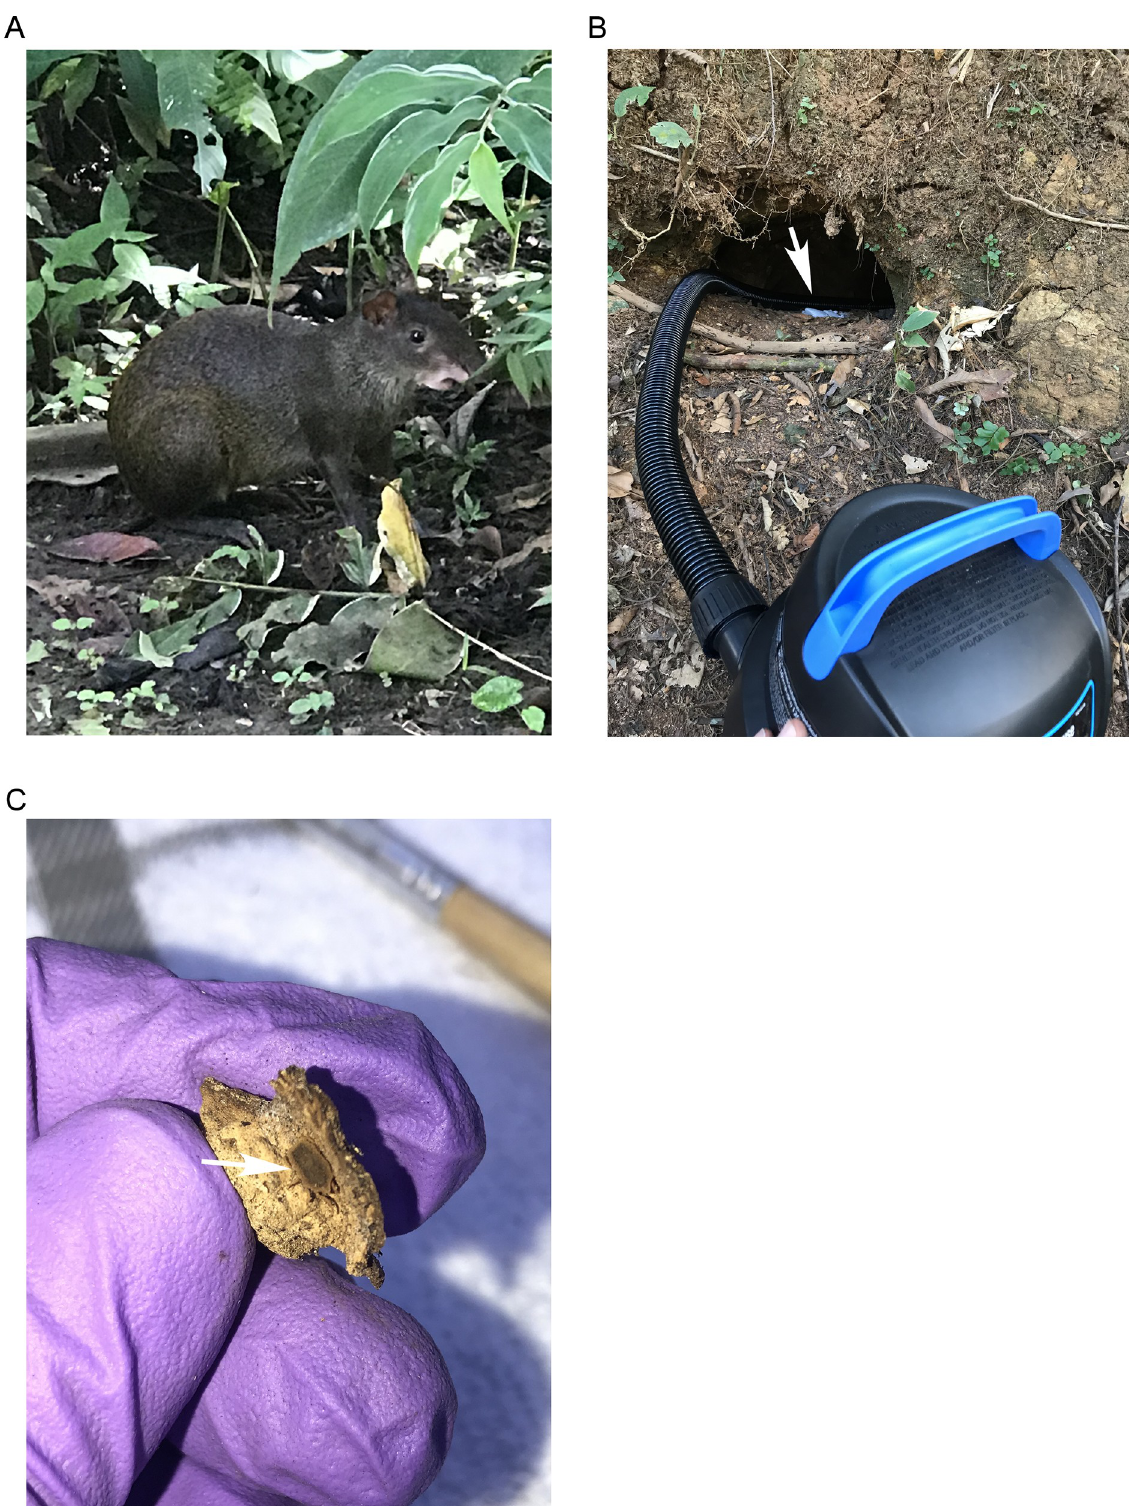
Fig 2. Habitat of Ornithodoros puertoricensis collections. At collections sites an abundance of Dasyprocta punctata was seen (A) and collection efforts were centered around their dens (B). Two methods were used to collect ticks. Dry ice (B, white arrow) was used as a source of carbon dioxide to lure ticks from within the dens. The dens were also aspirated (B). Debris from dens was evaluated and ticks were observed wedged between pieces of wood (C, white arrow). https://doi.org/10.1371/journal.pntd.0009642.g002 PLOS NeglectedTropical Diseases | https://doi.org/10.1371/journal.pntd.0009642 August 16,